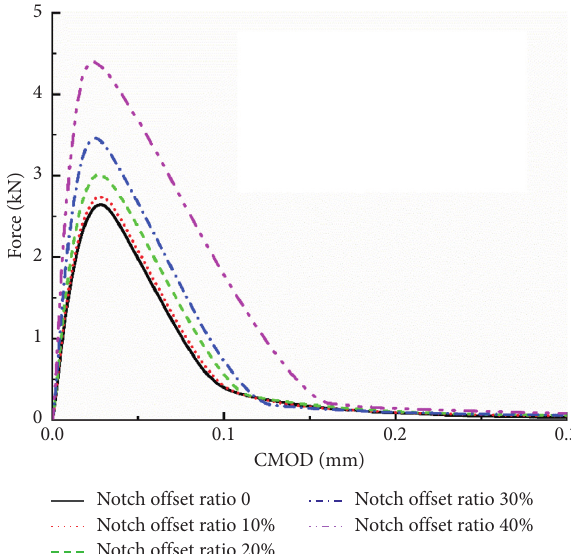
Figure 10: P-CMOD curves for the rock beams with different notch offset ratios.